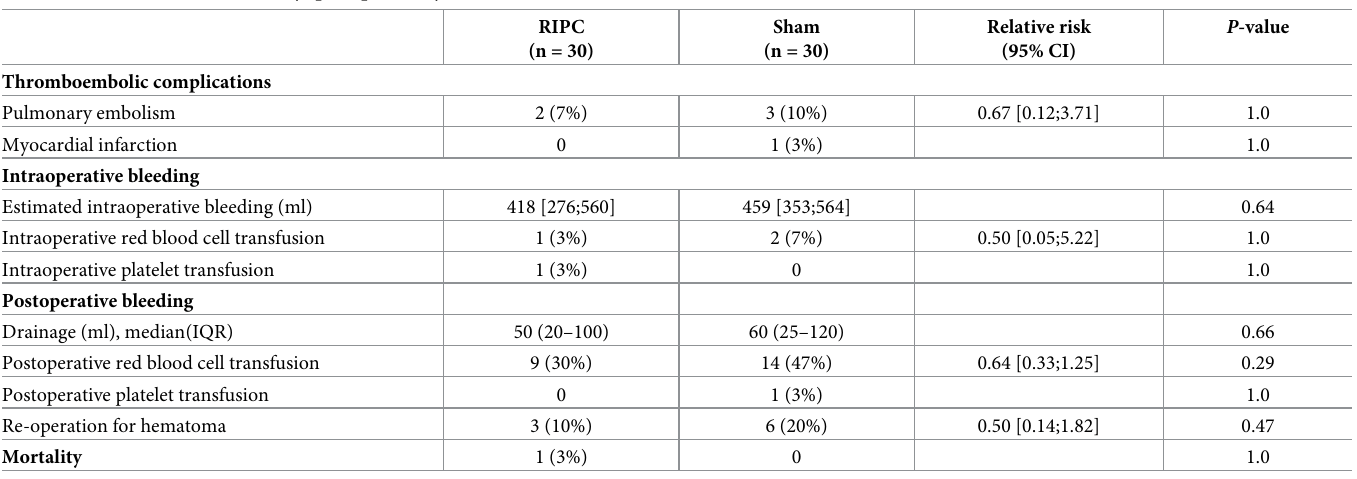
Table 3. Clinical outcomes at 30 days postoperatively.